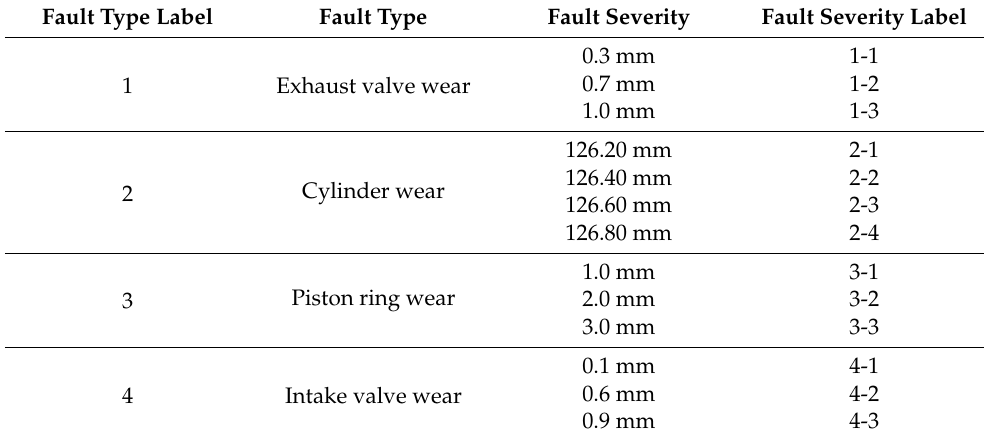
Table 1. Multi-fault diagnosis data set.